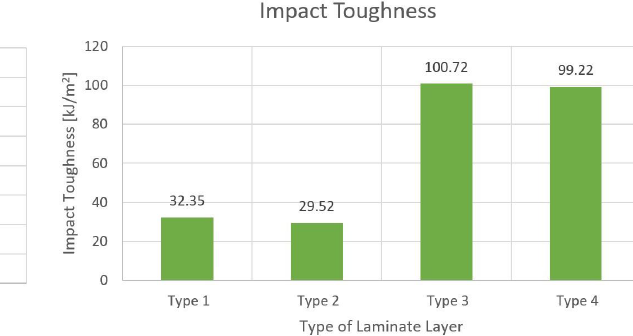
Figure 12: The impact energy of HCGFRP on each lamina configura- tion